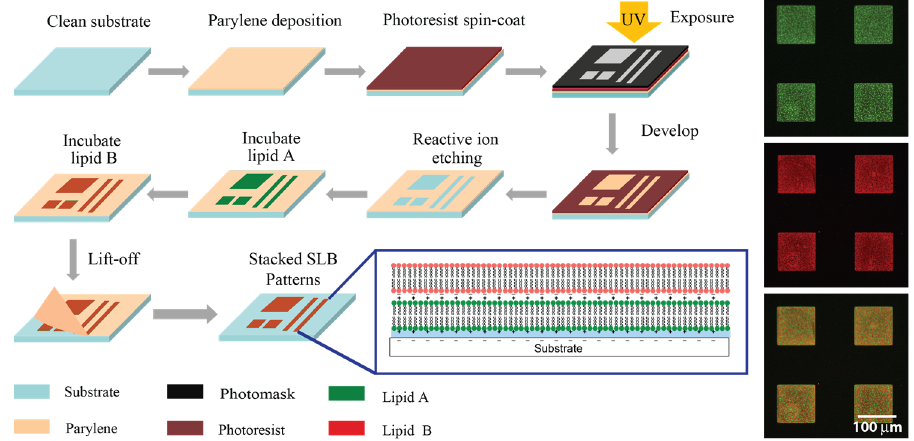
Figure 1. Illustration of the PSLO patterning process for stacked SLBs. Parylene film